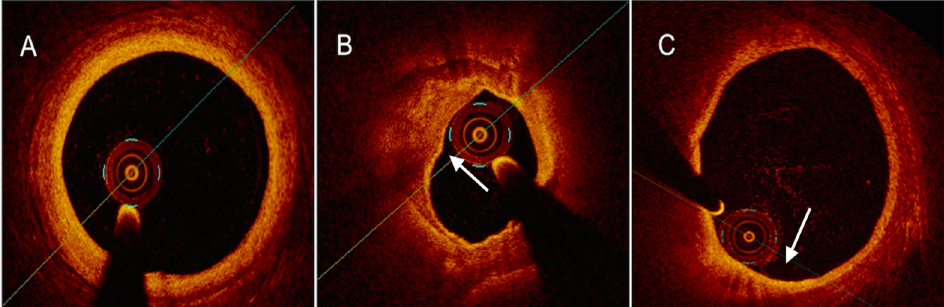
Figure 3. OCT images of coronary plaque phenotype. ( A ) Pathological intimal thickening, depicted as a homogeneous signal ‐ rich thick intimal band composed of fibrous tissue. ( B ) Calcific plaque (( B ), white arrow), depicted as a low ‐ backscattering structure, as compared to surrounding adventitia, with sharply delineated borders. ( C ) TCFA, depicted as a low ‐ density structure with diffuse borders covered by a thin fibrous cap. Macrophages (( C ), white arrow), identified as signal ‐ rich distinct or confluent punctate regions that exceed the intensity of background speckle noise, are often found in TCFAs.